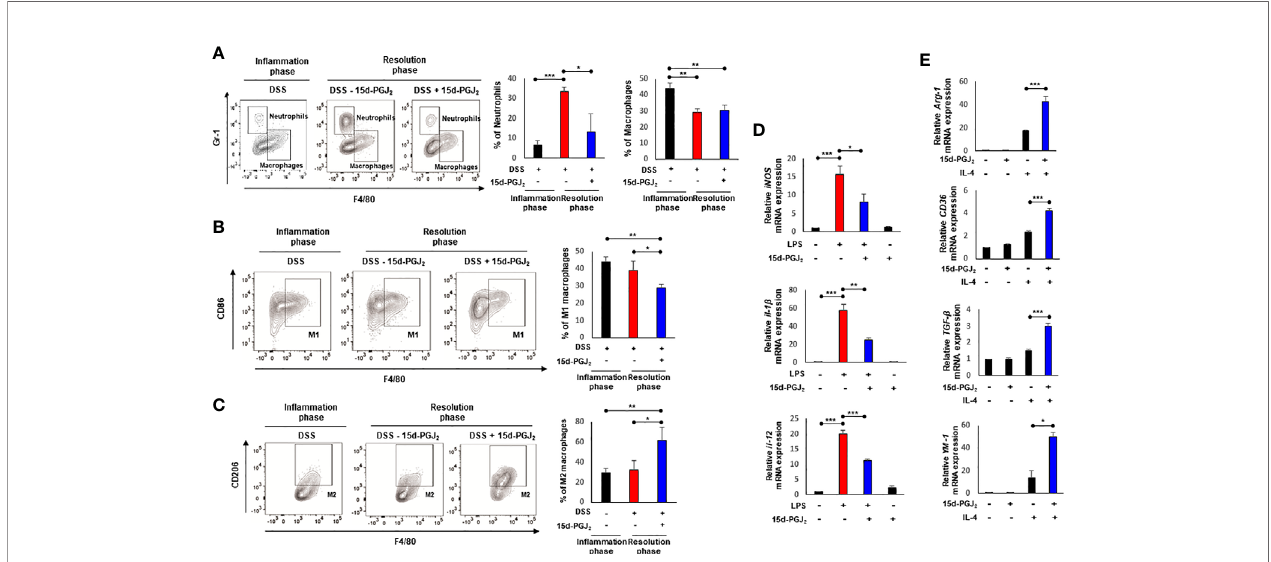
FIGURE 4 | 15d-PGJ 2 induces leukocyte in fi ltration and macrophage polarization. Lamina propria immune cells were isolated from the colons of DSS-treated mice, collected on day 7 (In fl ammation phase) and day 11 (Resolution phase) as described in Materials and Methods . (A – C) The percentage of neutrophils (CD45 + CD11b + Gr-1 + F4/80 - ) macrophages (CD45 + CD11b + Gr-1 - F4/80 + ), M1 macrophages (CD45 + CD11b + Gr-1 - F4/80 + CD86 + ), and M2 macrophages (CD45 + CD11b + Gr-1 - F4/80 + CD206 + ) was determined by fl ow cytometery. The graphs show the percentage of each cell population. (D) BMDMs were treated with LPS (100 ng/ml) in the absence or presence of 15d-PGJ 2 (10 m M). The mRNA levels of M1 markers including iNOS, IL-1 b , and IL-12 were measured by real-time PCR. (E) BMDMs were co-treated with IL-4 and 15d-PGJ 2 for 4 h. The mRNA levels of M2 markers including Arg-1 , CD36 , TGF- b , and YM-1 were determined by real- time PCR. All data represent mean ± S.D. (n=3). * p < 0.05, ** p < 0.01, and *** p <